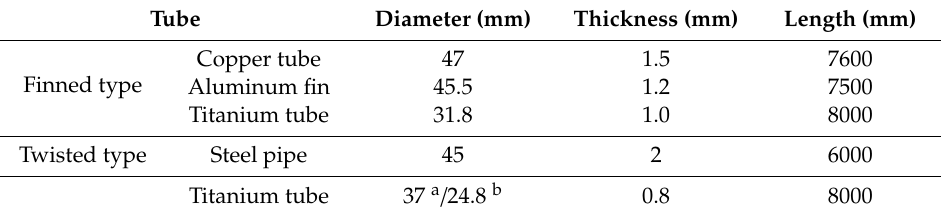
Table 1. Specifications of tubes for double pipe heat exchangers.